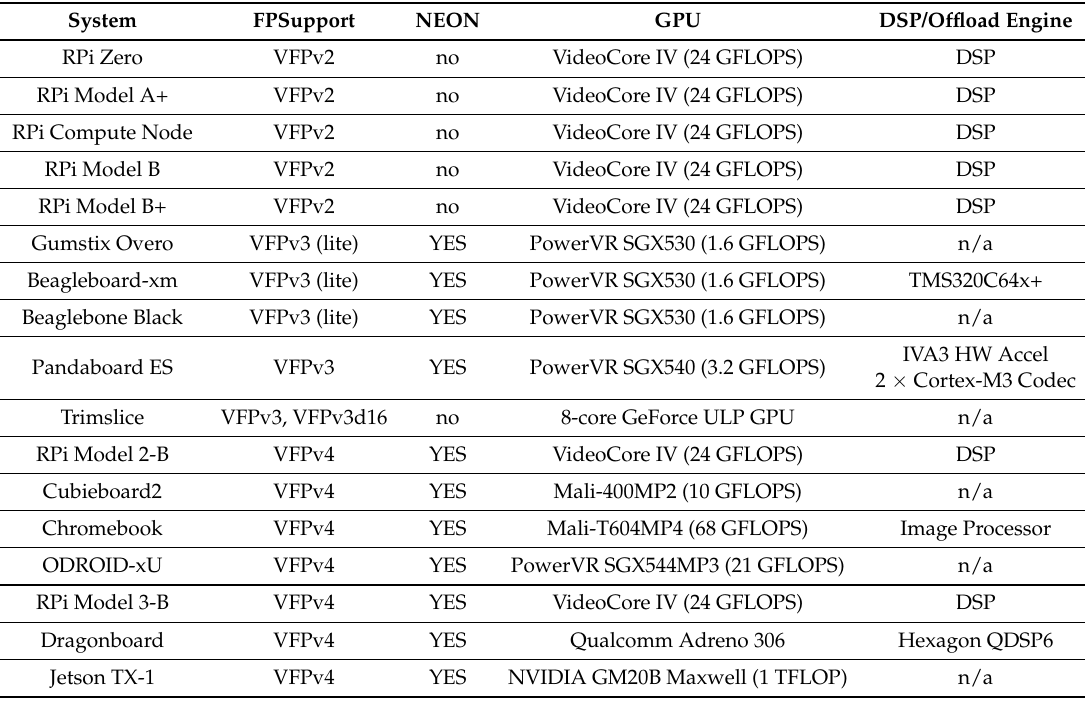
Table A2. Floating point and GPU configurations of the boards.